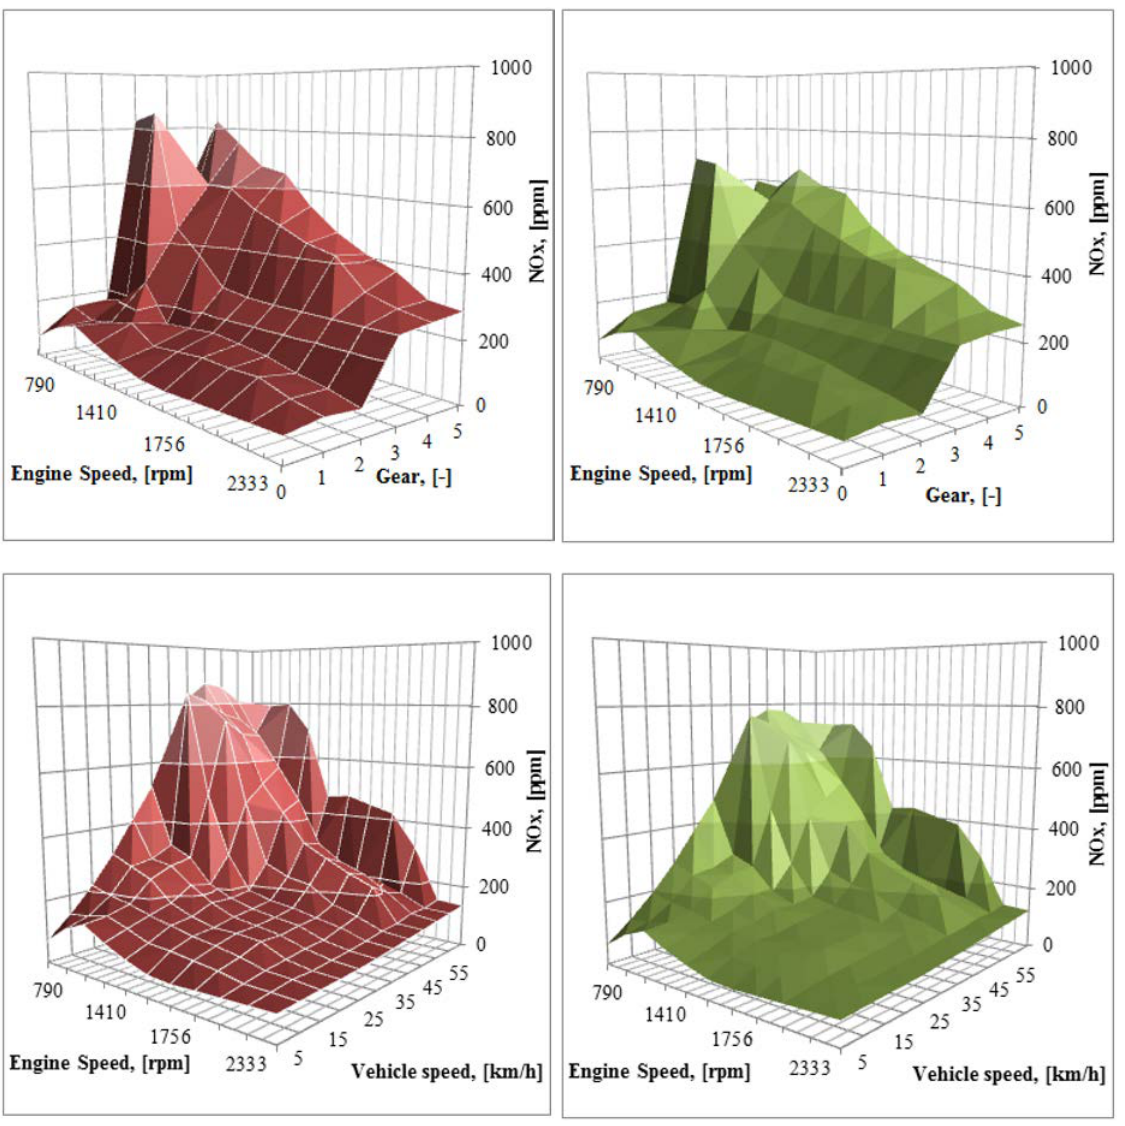
Figure 12. Nitruos oxide emission variations. a. NOx versus engine speed for different gear ratios in standard operating conditions; b. NOx versus engine speed for different gear ratios with IAP operation; c. NOx versus engine speed for different vehicle speeds in standard operation; d. NOx versus engine speed for different vehicle speeds with IAP